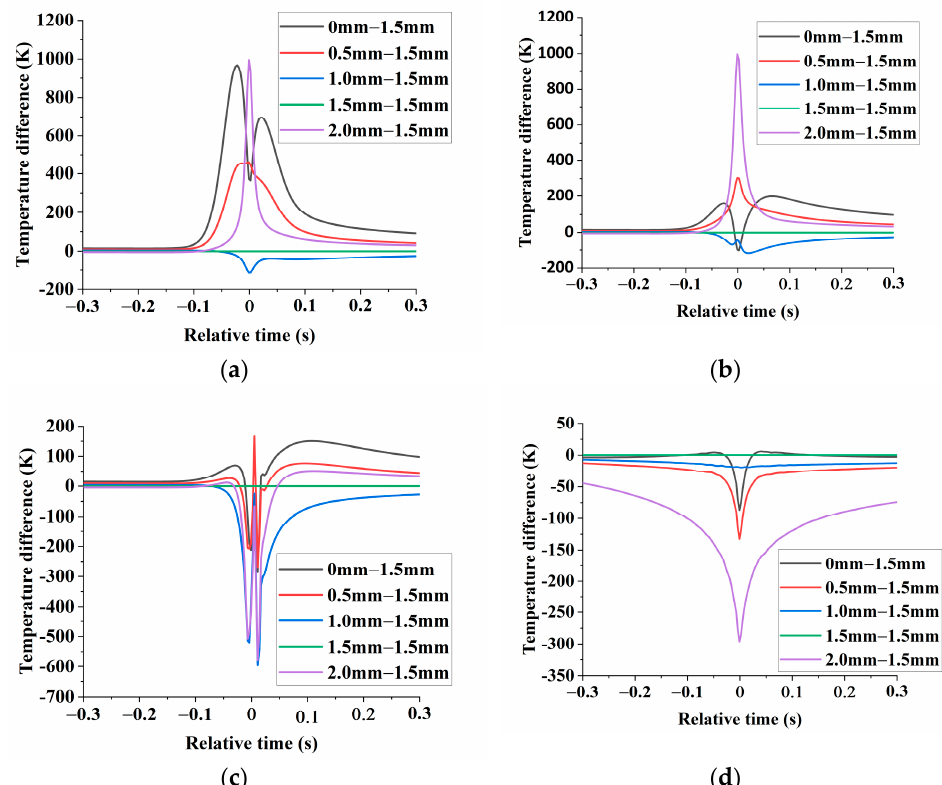
Figure 8. Compared with 1.5 mm weld spacing, the difference between the monitoring points of the same z value of the second weld at other weld spacing. ( a ) monitoring points ( z = 0mm ) ; ( b ) monitoring points ( z = − 0.5mm ) ; ( c ) monitoring points ( z = − 1.0mm ) ; ( d ) monitoring points ( z = − 1.5mm ) .